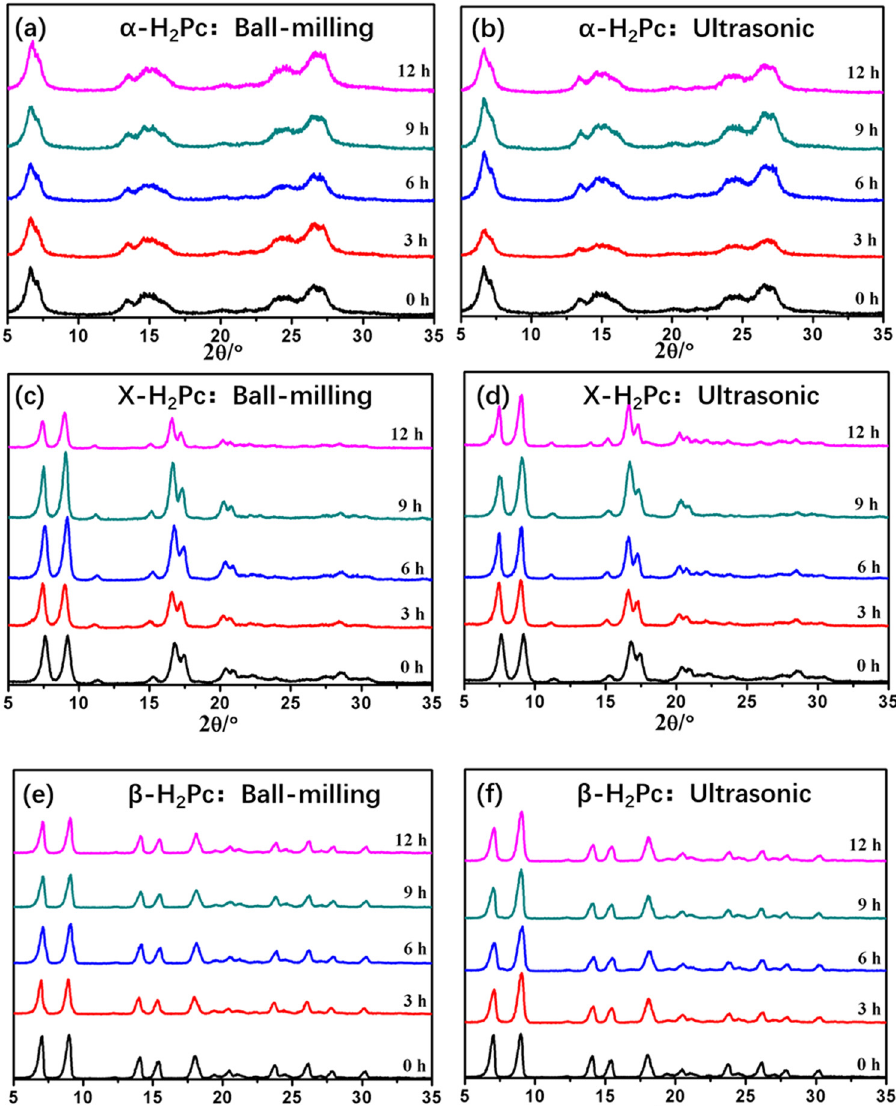
Figure 3: XRD patterns of α - , X - , and β - H 2 Pc before and after ball - milling treatment ( a, c, and e ) and ultrasonic ( b, d, and f ) for 0 – 12 h,